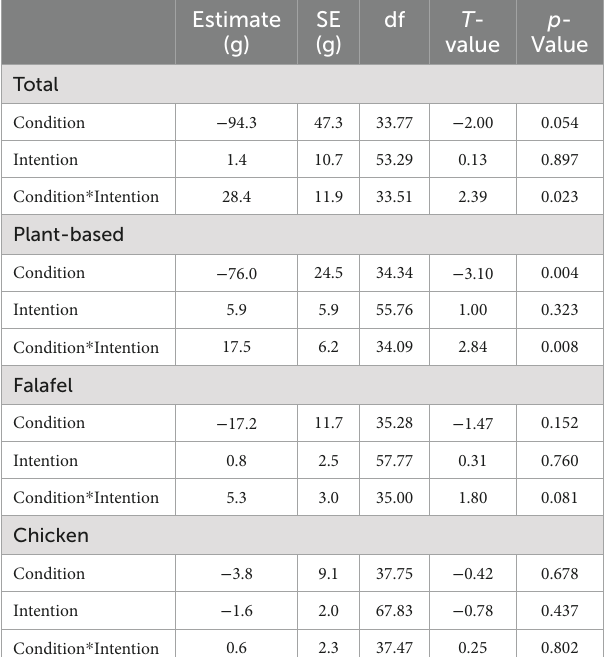
TABLE 1 Effect of the presence of a vegetarian confederate and of vegetarian intentions, as well as of their interaction, on intakes at the